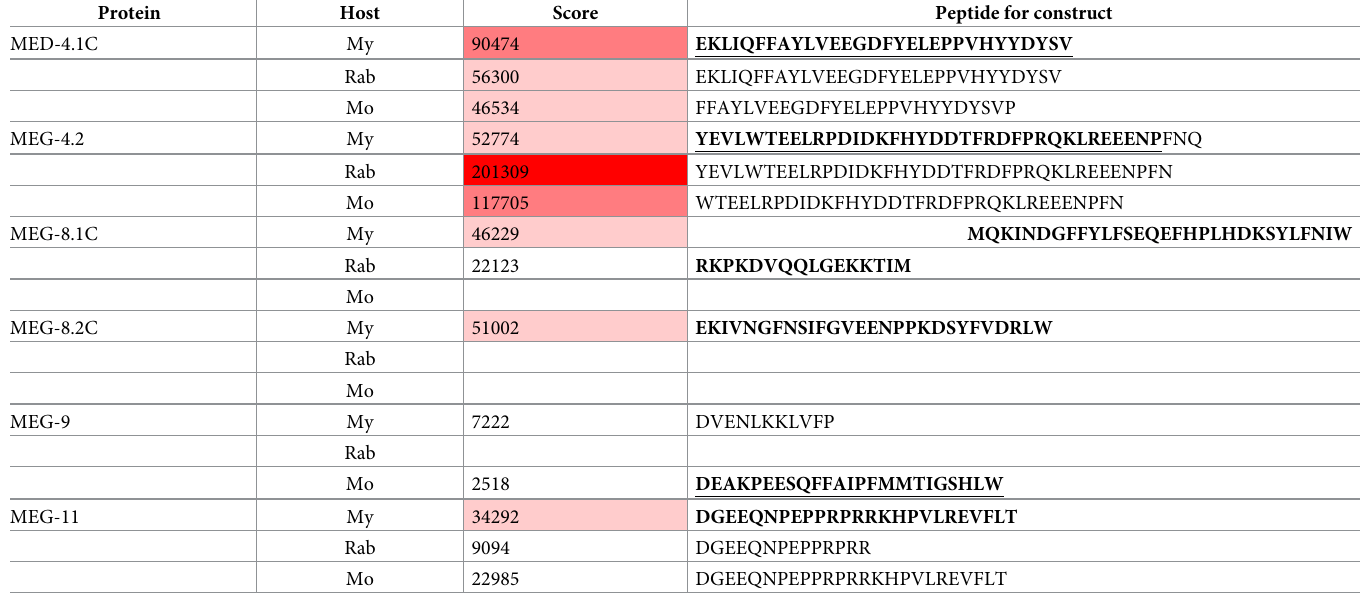
Table 1. Peptide selection for a synthetic